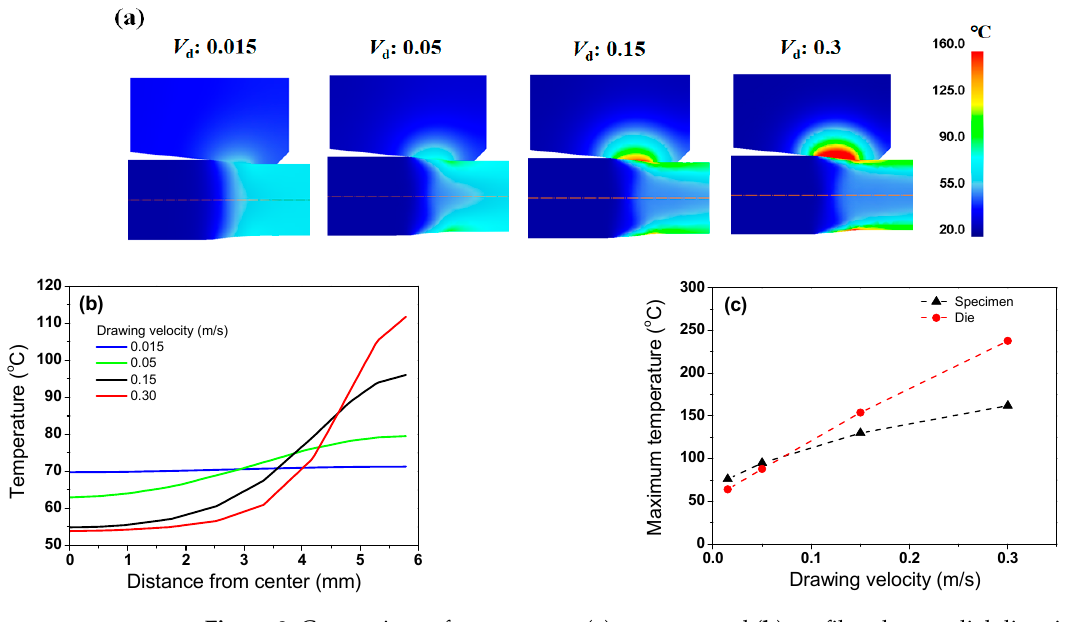
Figure 8. Comparison of temperature ( a ) contours and ( b ) profiles along radial direction of wire at die exit; ( c ) T max of wire and die vs. drawing velocity.